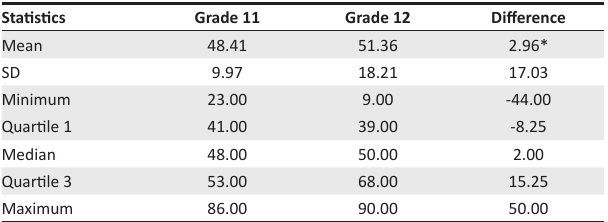
TABLE 3: Descriptive statistics for Grade 11 and Grade 12 mathematics marks ( N = 184).